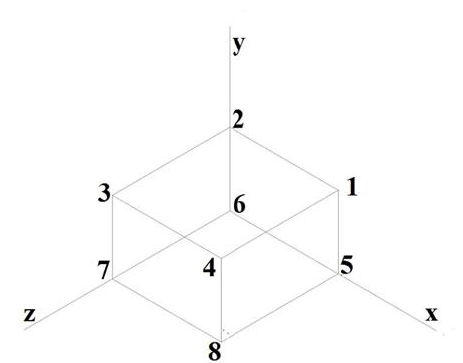
Figure 2: Eight node solid element in STAAD - pro V8i